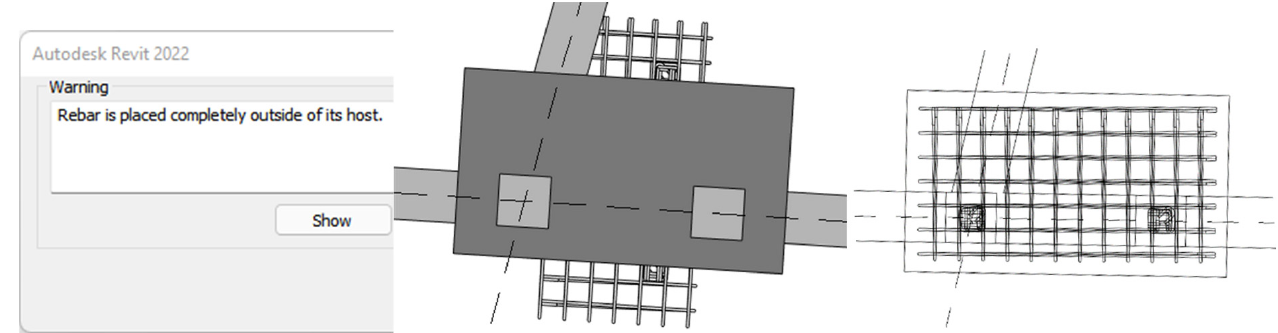
Figure 17. Foundation reinforcements before and after the correction has been made.